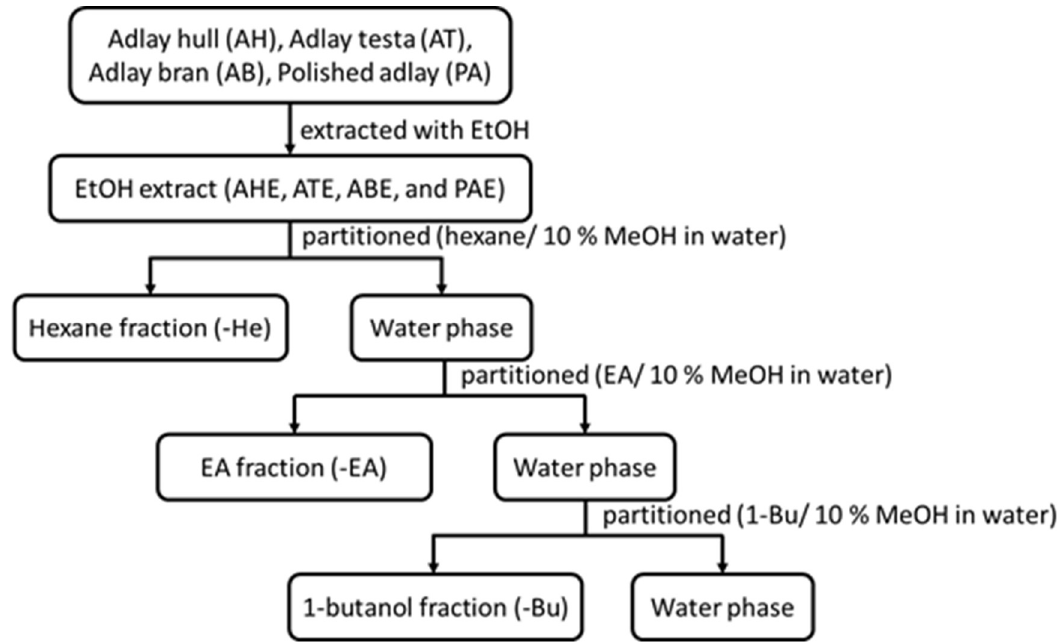
Figure 5. The solvent partitions of the ethanolic extracts from different parts of the adlay